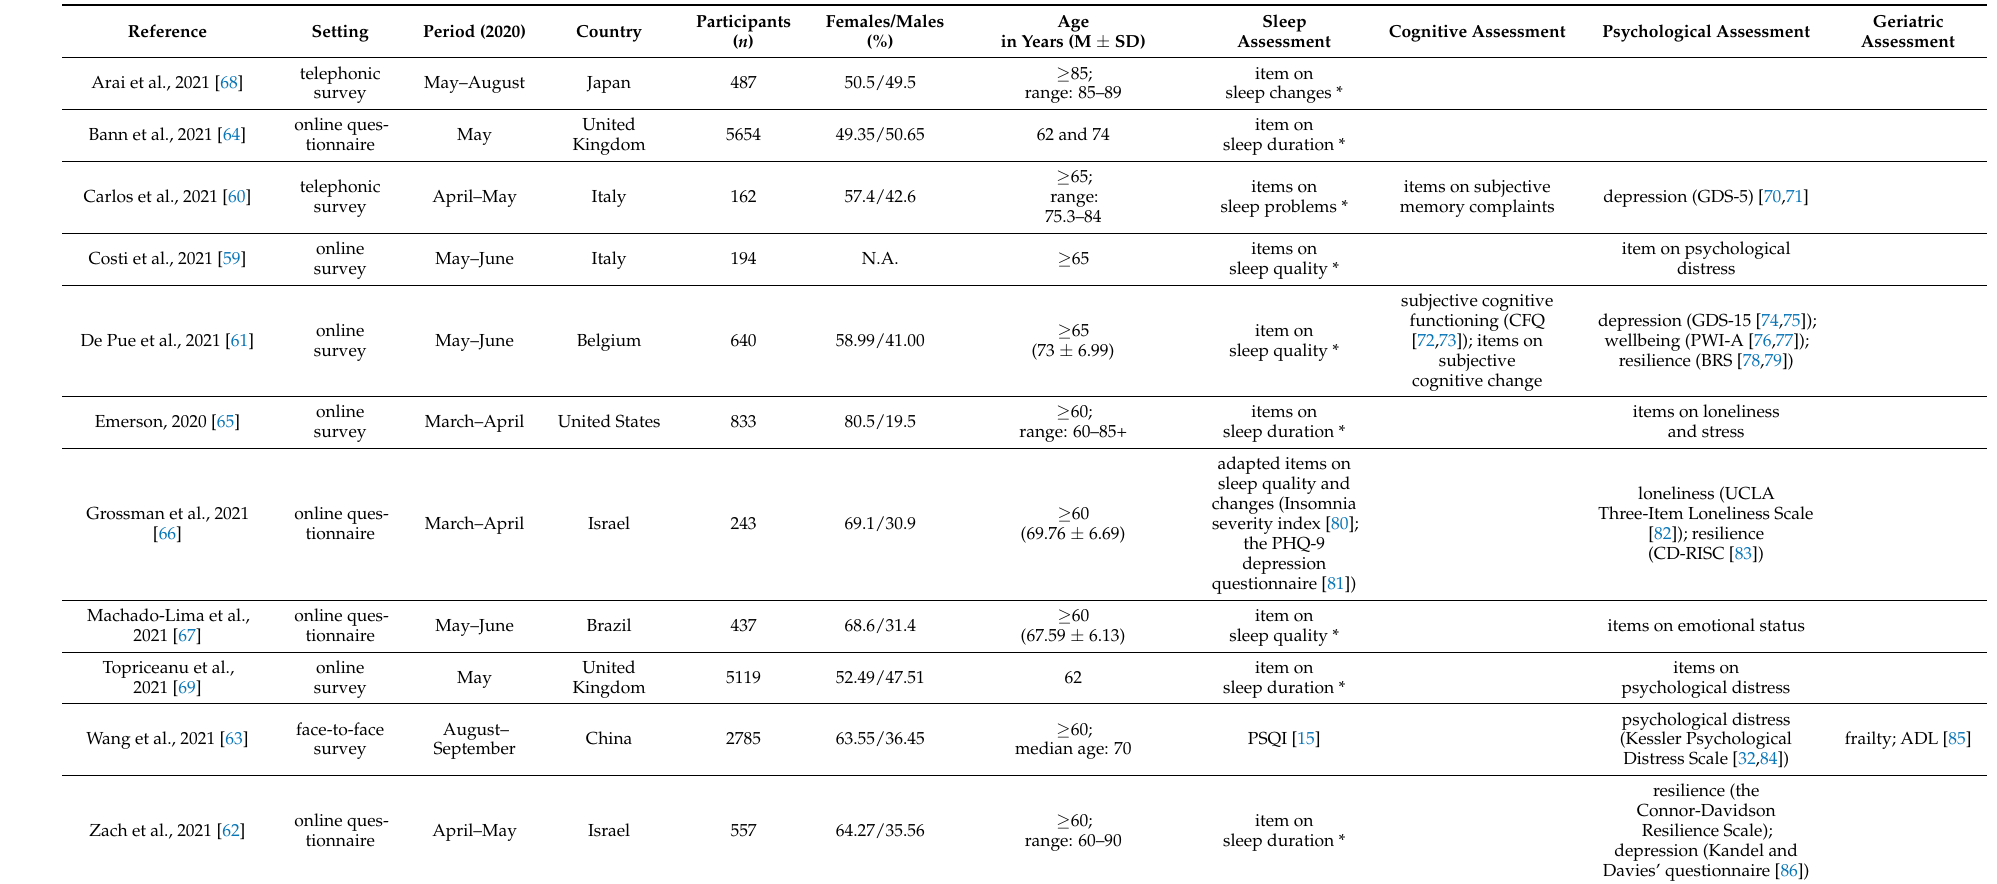
Table 1. Characteristics of the 11 studies included in the